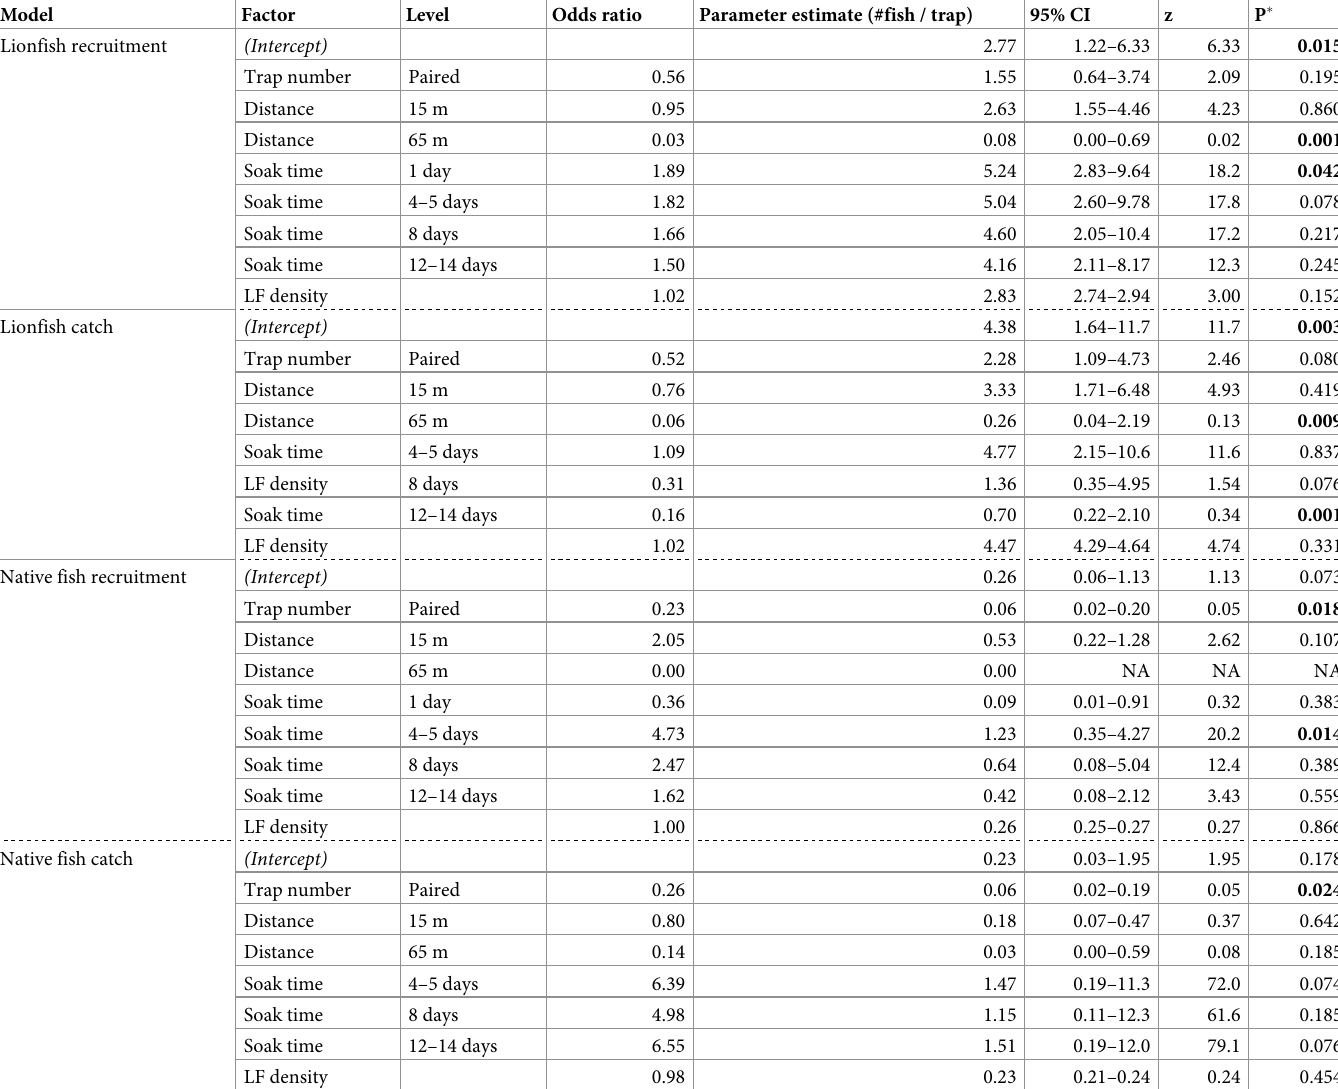
Table 3. Generalized mixed model results testing deployment factors on lionfish and native fish species recruitment and catches by Gittings traps.